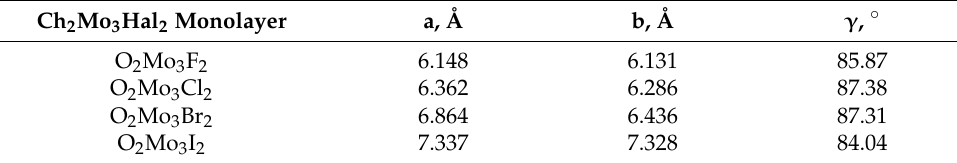
Table 2. Unit cell parameters for Ch 2 Mo 3 Hal 2 (Ch = O, S, Se, Te; Hal = F, Cl, Br, I) Chevrel